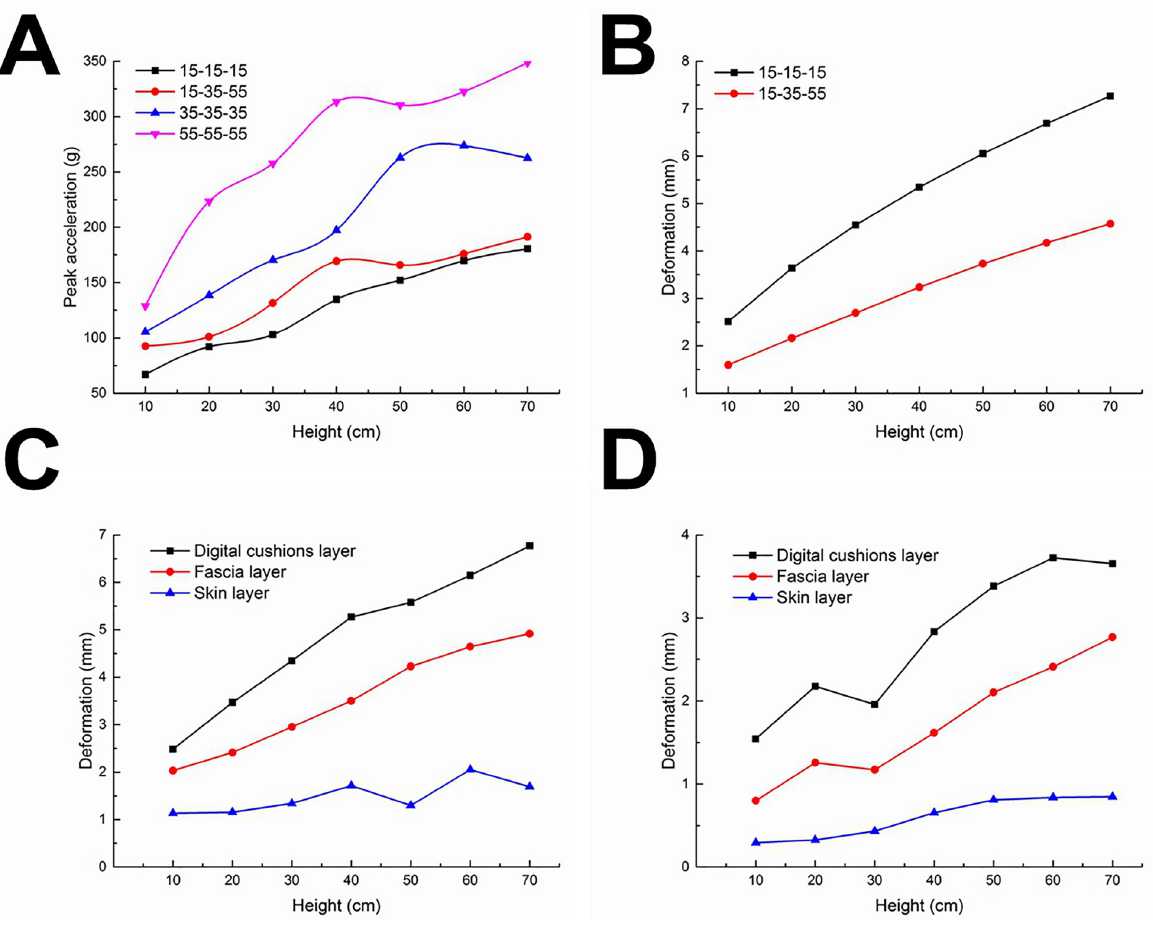
Fig 4. Quantitative comparisons of cushioning performances and stabilities among the bio-inspired feet on loose sand in the FEM simulations. (A) Cushioning performance, (B) total deformation; single-layer deformation of (C) 15-15-15 HA and (D) 15-35-55 HA bio-inspired